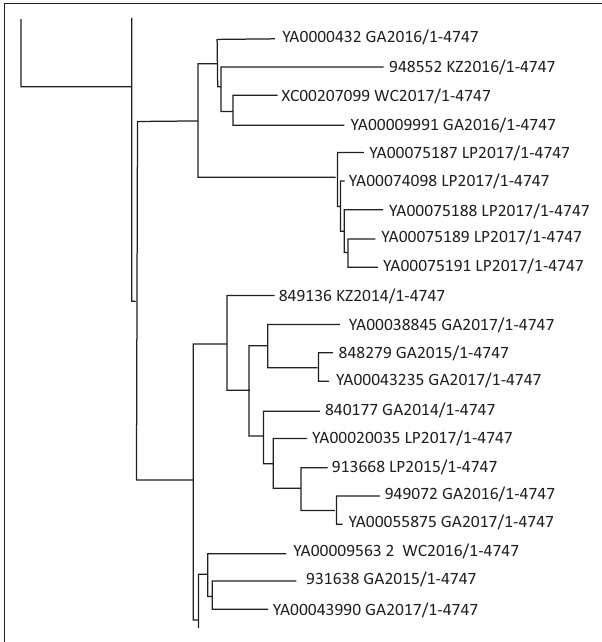
FIGURE 3: Epidemic curve of typhoid fever cases (suspected and confirmed) by date of onset, Sekhukhune District, Limpopo province, November – December 2017 ( N = 122).